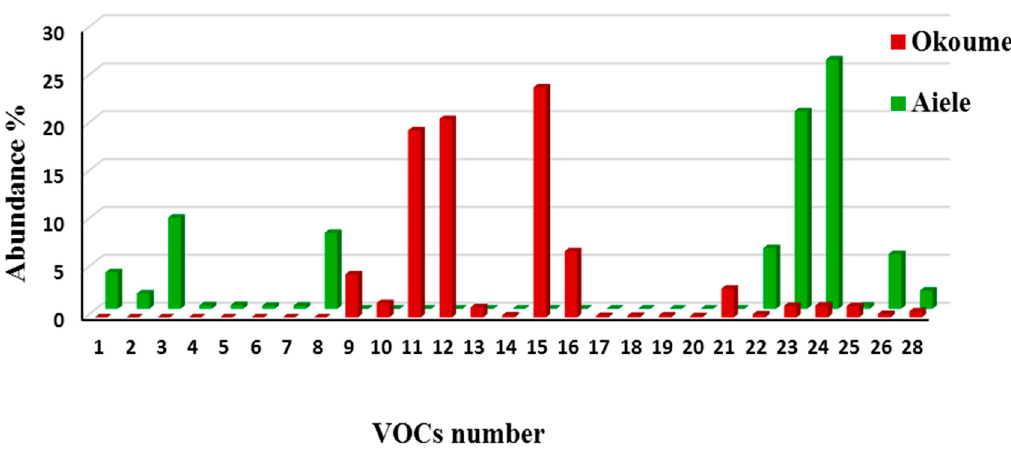
Figure 2. Histogram of the identified volatile compound of aiele and okoume essential oils by GC-MS analysis. The VOC numbers correspond to those used in Table 2.